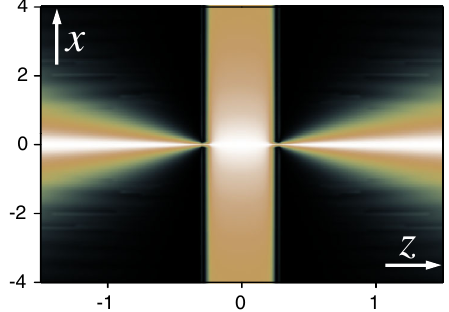
FIG. 3. Contour plot of j E y ð x; z Þ =E y ð 0 ; z Þj 2 for & ¼ & R . The values are the same as in Fig. 2(b).